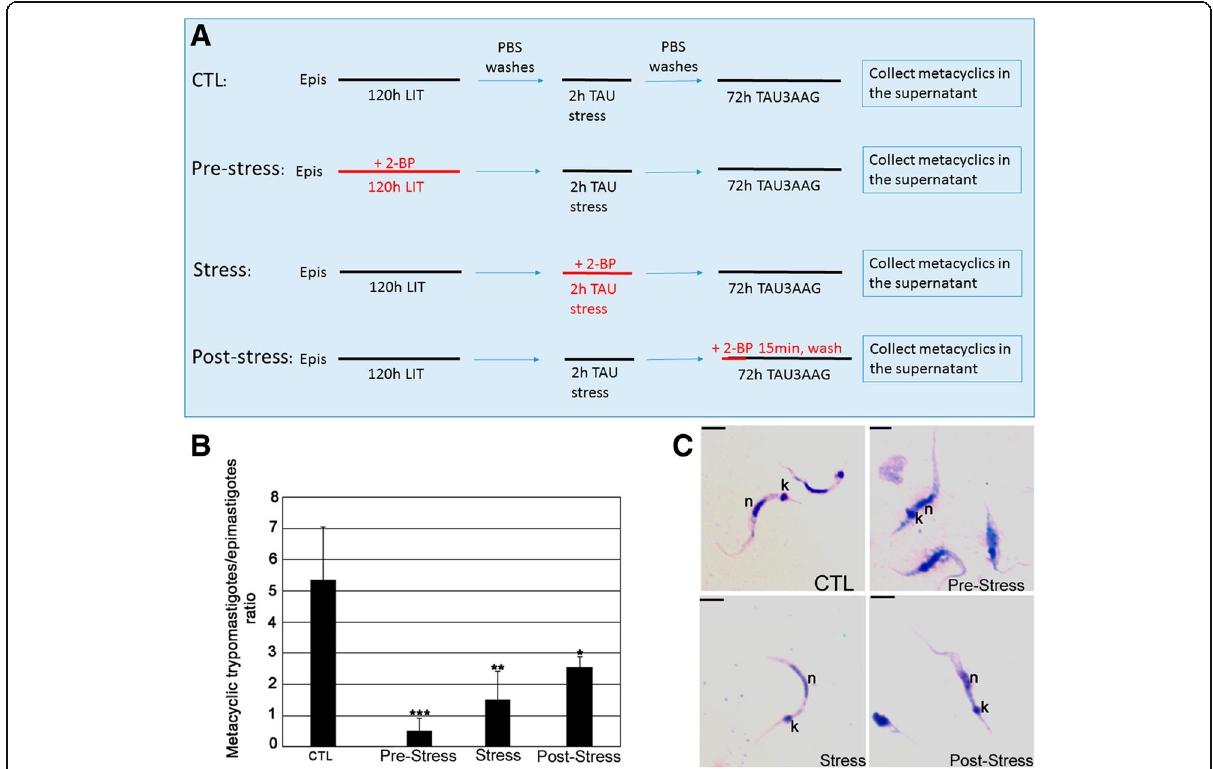
Fig. 7 Metacyclogenesis of Trypanosoma cruzi is inhibited by 2-BP treatment. a Schematic view of the metacyclogenesis experimental design. b Ratio of metacyclic trypomastigotes/epimastigotes after 72 h in the supernatant of TAU3AAG medium; the ratio decreased in all treatments, when compared to the untreated control. *: p > 0.005; **: p < 0.005; ***: p < 0.001. c Giemsa-stained cells collected in the supernatant showing morphological alterations after the different treatments. n: nucleus; k: kinetoplast. Bars = 5 μ